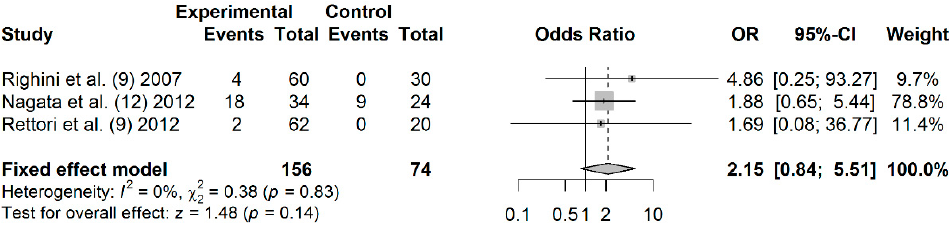
Figure 7. Forest plot for the association between APC promoter hypermethylation and HNC risk. The squares represent the ORs for individual studies. Bars represent the 95% CIs. The center of the diamond represents the summary effect size.